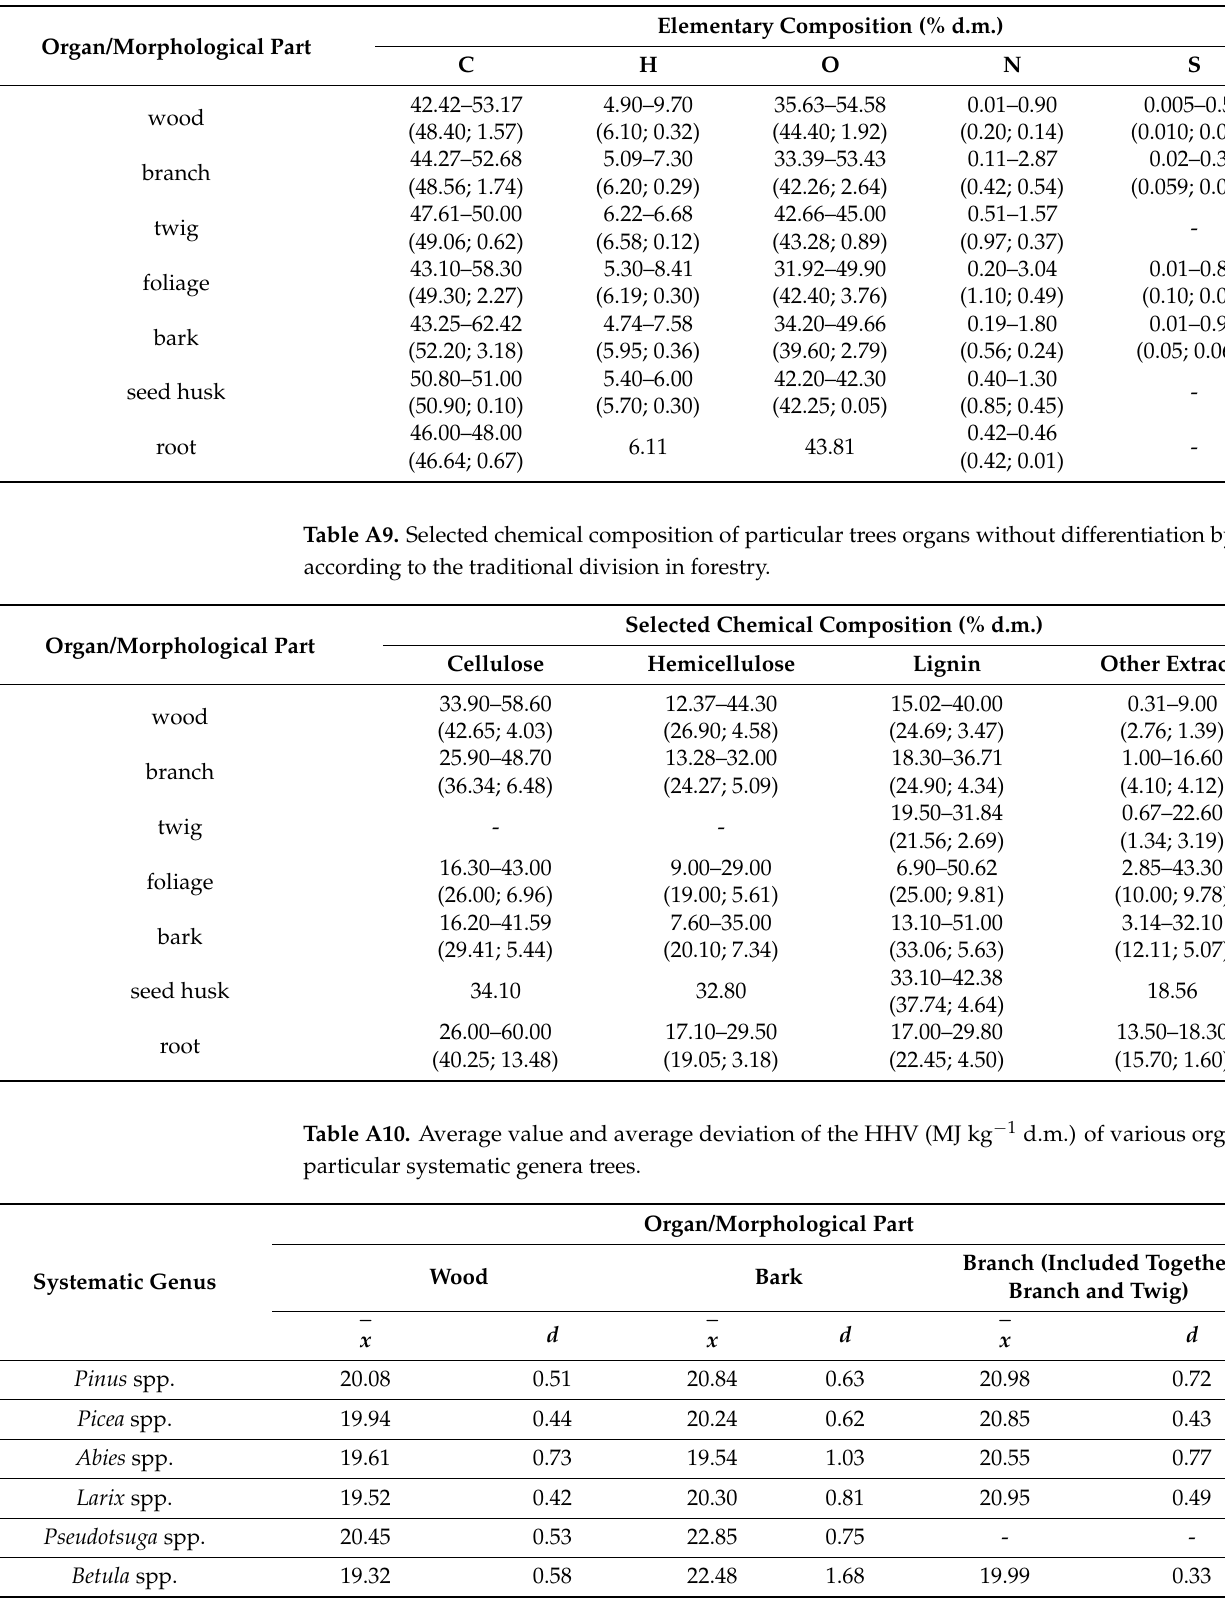
Table A8. Elementary composition/ultimate analyses of particular trees organs without differentia- tion by type according to the traditional division in forestry.